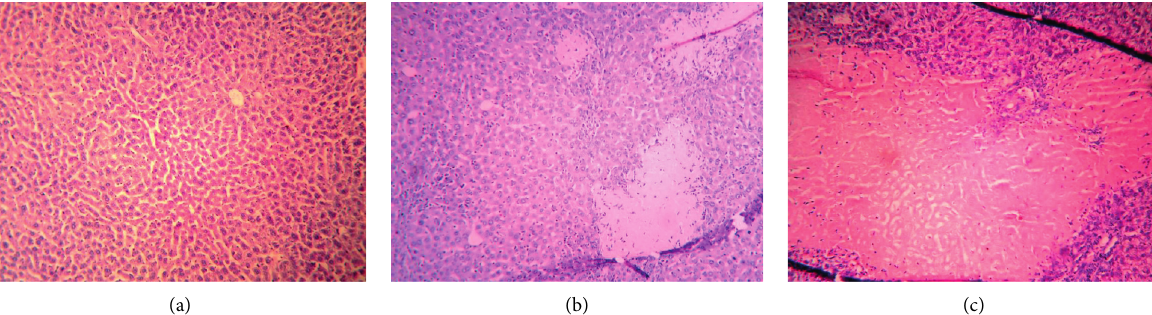
Figure 1: Changes in the hepatocytes stained H&E after DBDCT exposure (magnification: 10 × ). (a) H&E-stained image of the control hepatocytes. (b, c) The images of the hepatocytes treated with DBDCT.